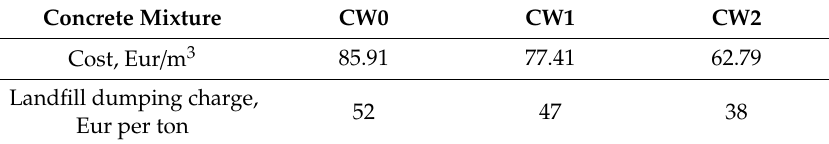
Table 6. Concrete mixture costs and landfill dumping charge